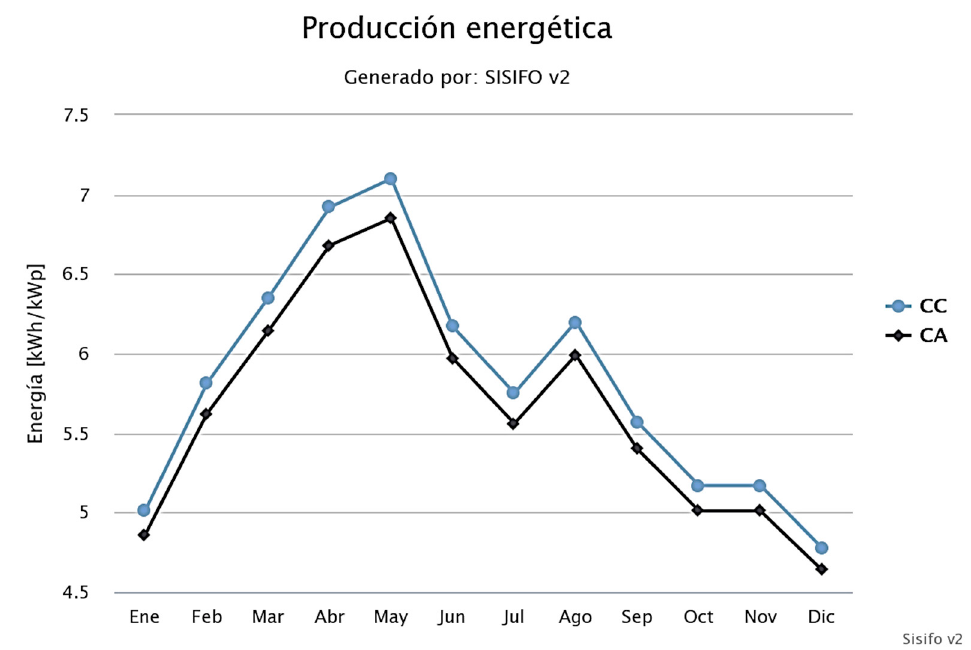
Figure 1. Electric generation of a solar collector for a conventional house a whole solar